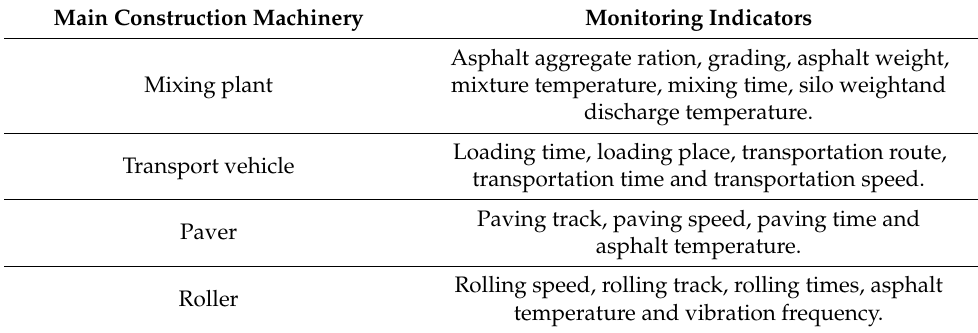
Table 1. Main monitoring indicators of digital monitoring